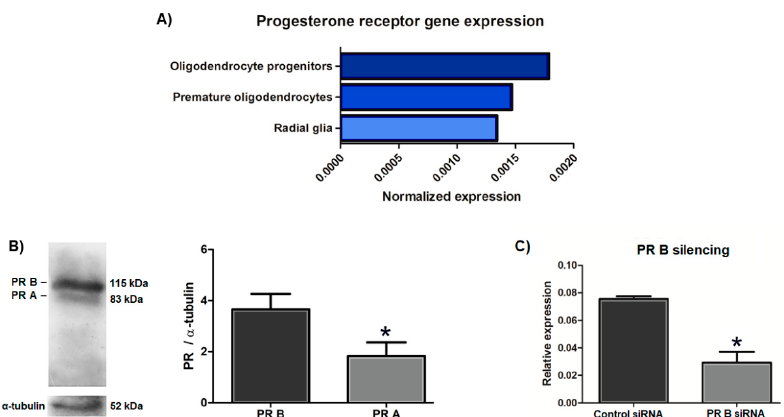
Figure 6. The OPC from the mouse embryonic spinal cord express both progesterone receptor (PR) isoforms. ( A ) PR gene expression analyzed by single cell RNA-seq in radial glial cells, oligodendrocyte progenitors, and premature oligodendrocytes from E9.5-E13.5 whole mouse embryos obtained from the “Mouse Organogenesis Cell Atlas” [50]. ( B ) PR-A and PR-B expression detected by Western blot in the cultured OPC derived from the spinal cord of E14.5 mouse embryos. ( C ) PR-B silencing by siRNA transfection in the cultured OPC corroborated by RT-qPCR. Results are expressed as the mean ± S.E.M. n = 3; * p < 0.05 vs. PR-B; * p < 0.05 vs. control siRNA. Cells 2019 , 8 , x FOR PEER REVIEW